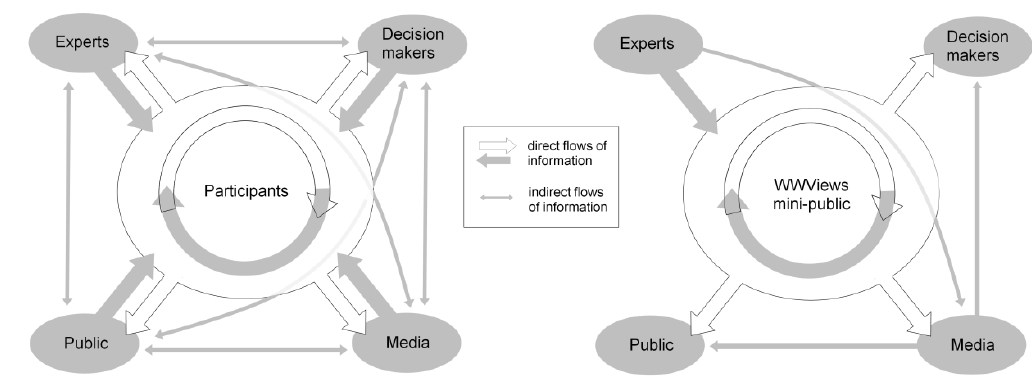
Figure 5. Direct and indirect flows of information in participatory